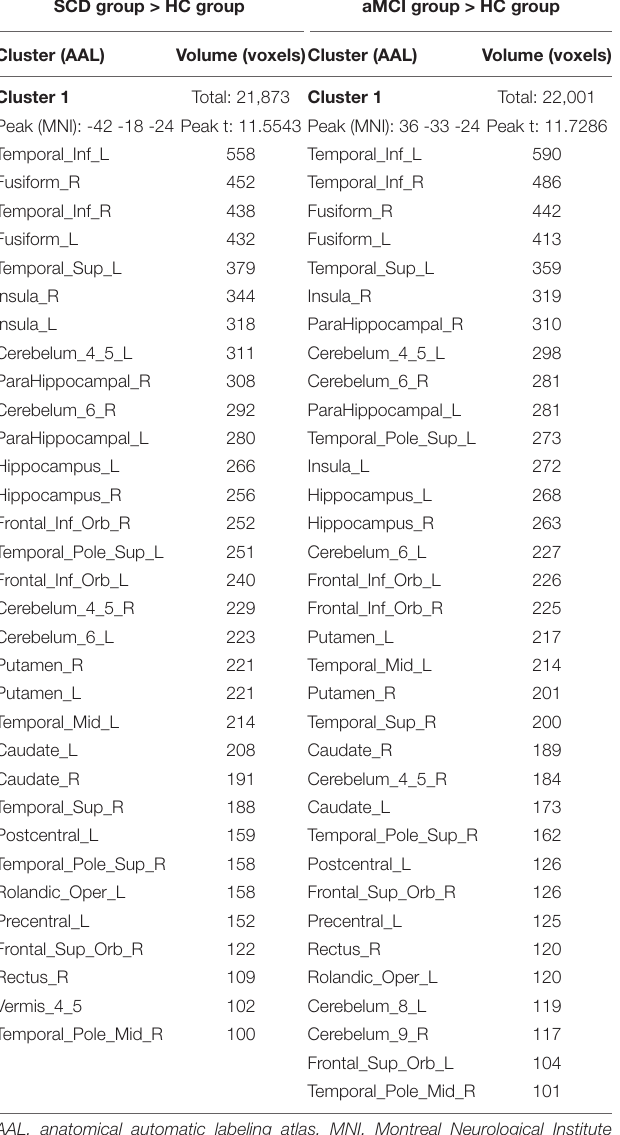
TABLE 3 | Brain regions with decreased ReHo in the SCD group and the aMCI group compared to the HC group. SCD group < HC group